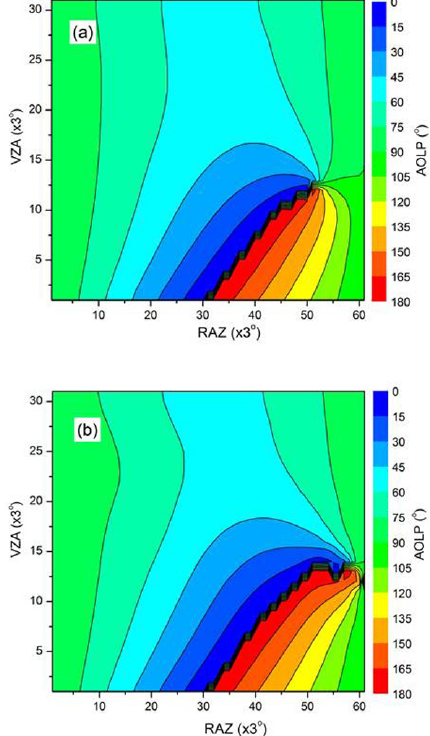
Fig. 25. Same as in Fig. 24, but for the AOLPs of the ocean– atmosphere system (a) without ice cloud and (b) with an ice cloud of optical thickness 0.3 at 865nm,